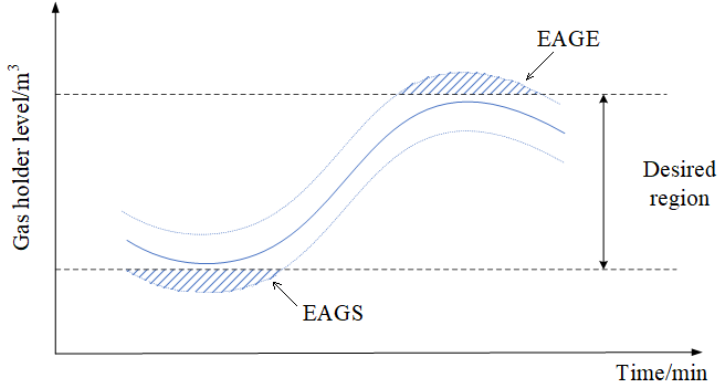
Figure 2. Schematic diagram of expected additional gas shortage and emission.